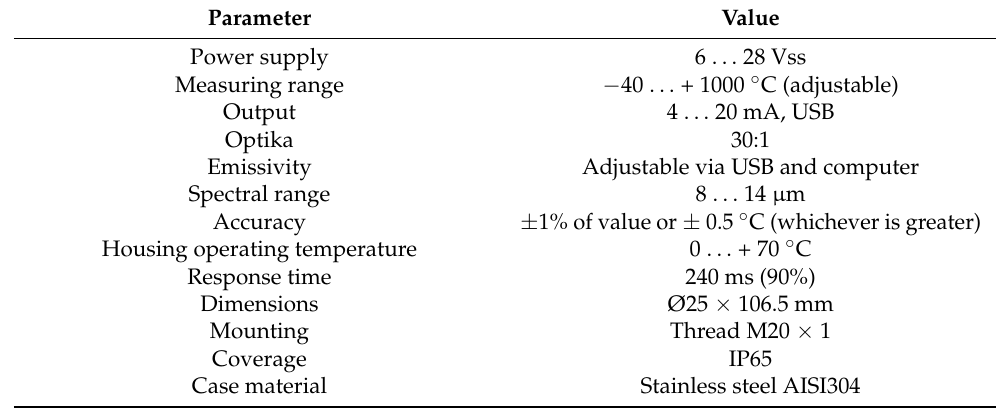
Table 3. Temperature sensor parameters.